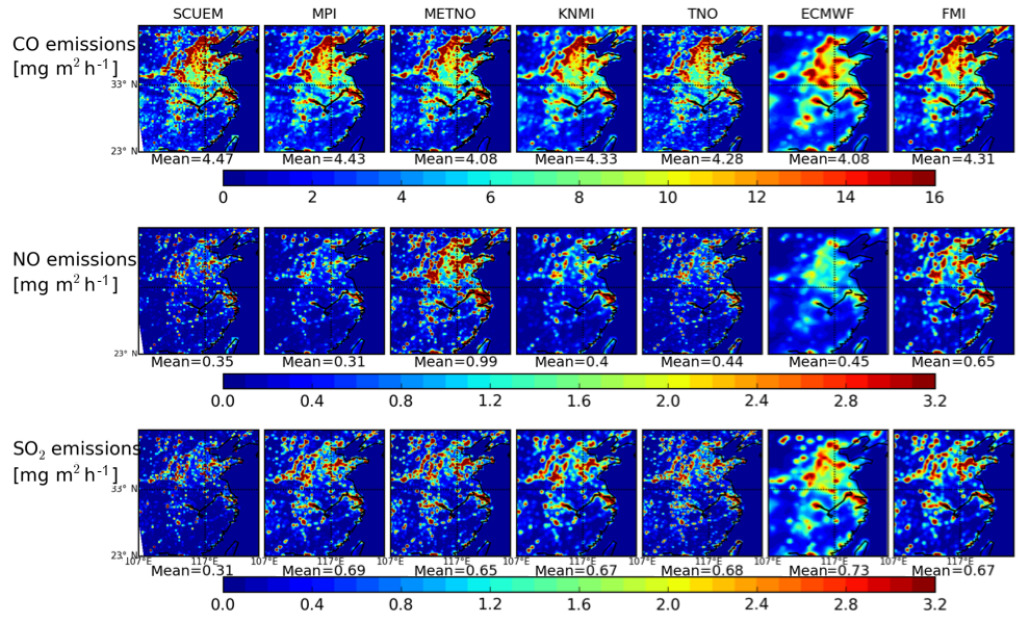
Figure 1. Surface emissions of CO, NO, and SO 2 (mgm − 2 h − 1 ) adopted by the different models (average for the period 1–14 March 2017). Note that the SCUEM emissions are those used in the WRF-Chem-SMS